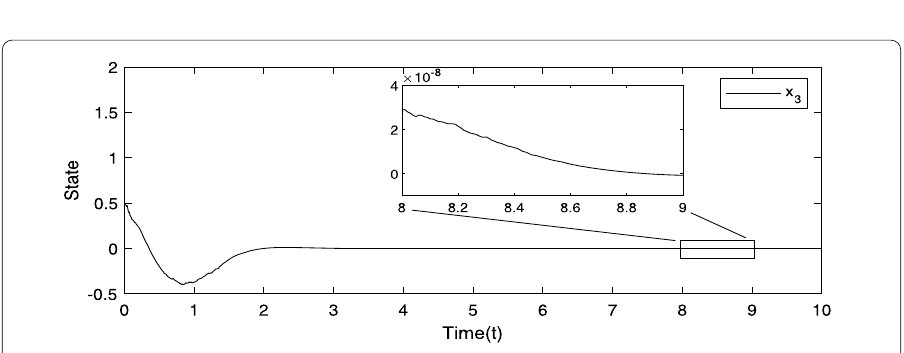
Figure 3 Response trajectory of state x 2 for the open-loop systems with uncertainties